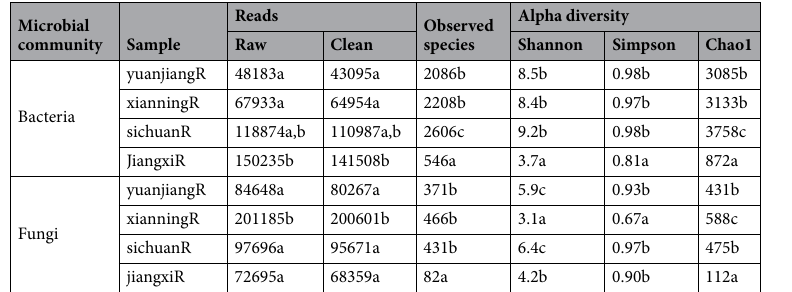
Table 2. Illumina Miseq reads, number of operational taxonomic units (OUTs), and alpha diversity of continuous cropping ramie in different areas. Notes: the a, b, c and d indicate significant differences at p =